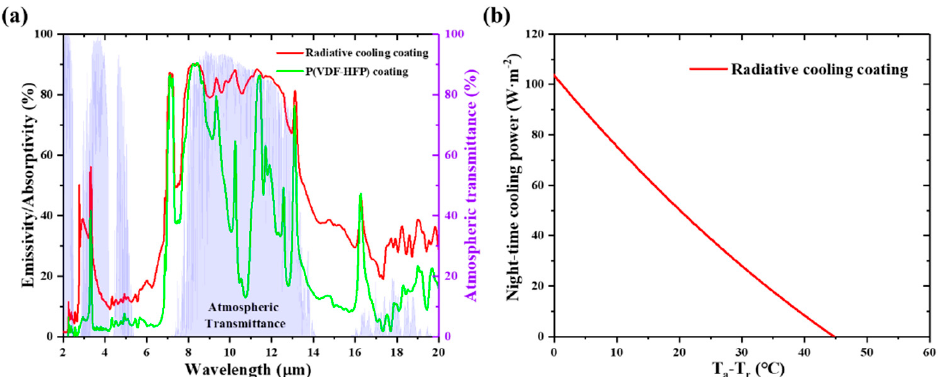
Figure 4. ( a ) IR emissivity / absorptivity of poly(vinylidene fluoride-co-hexafluoropropene) (P(VDF-HFP)) coating and radiative cooling coating; ( b ) Theoretical nighttime cooling performance of radiative cooling coating with relative humidity 60%.